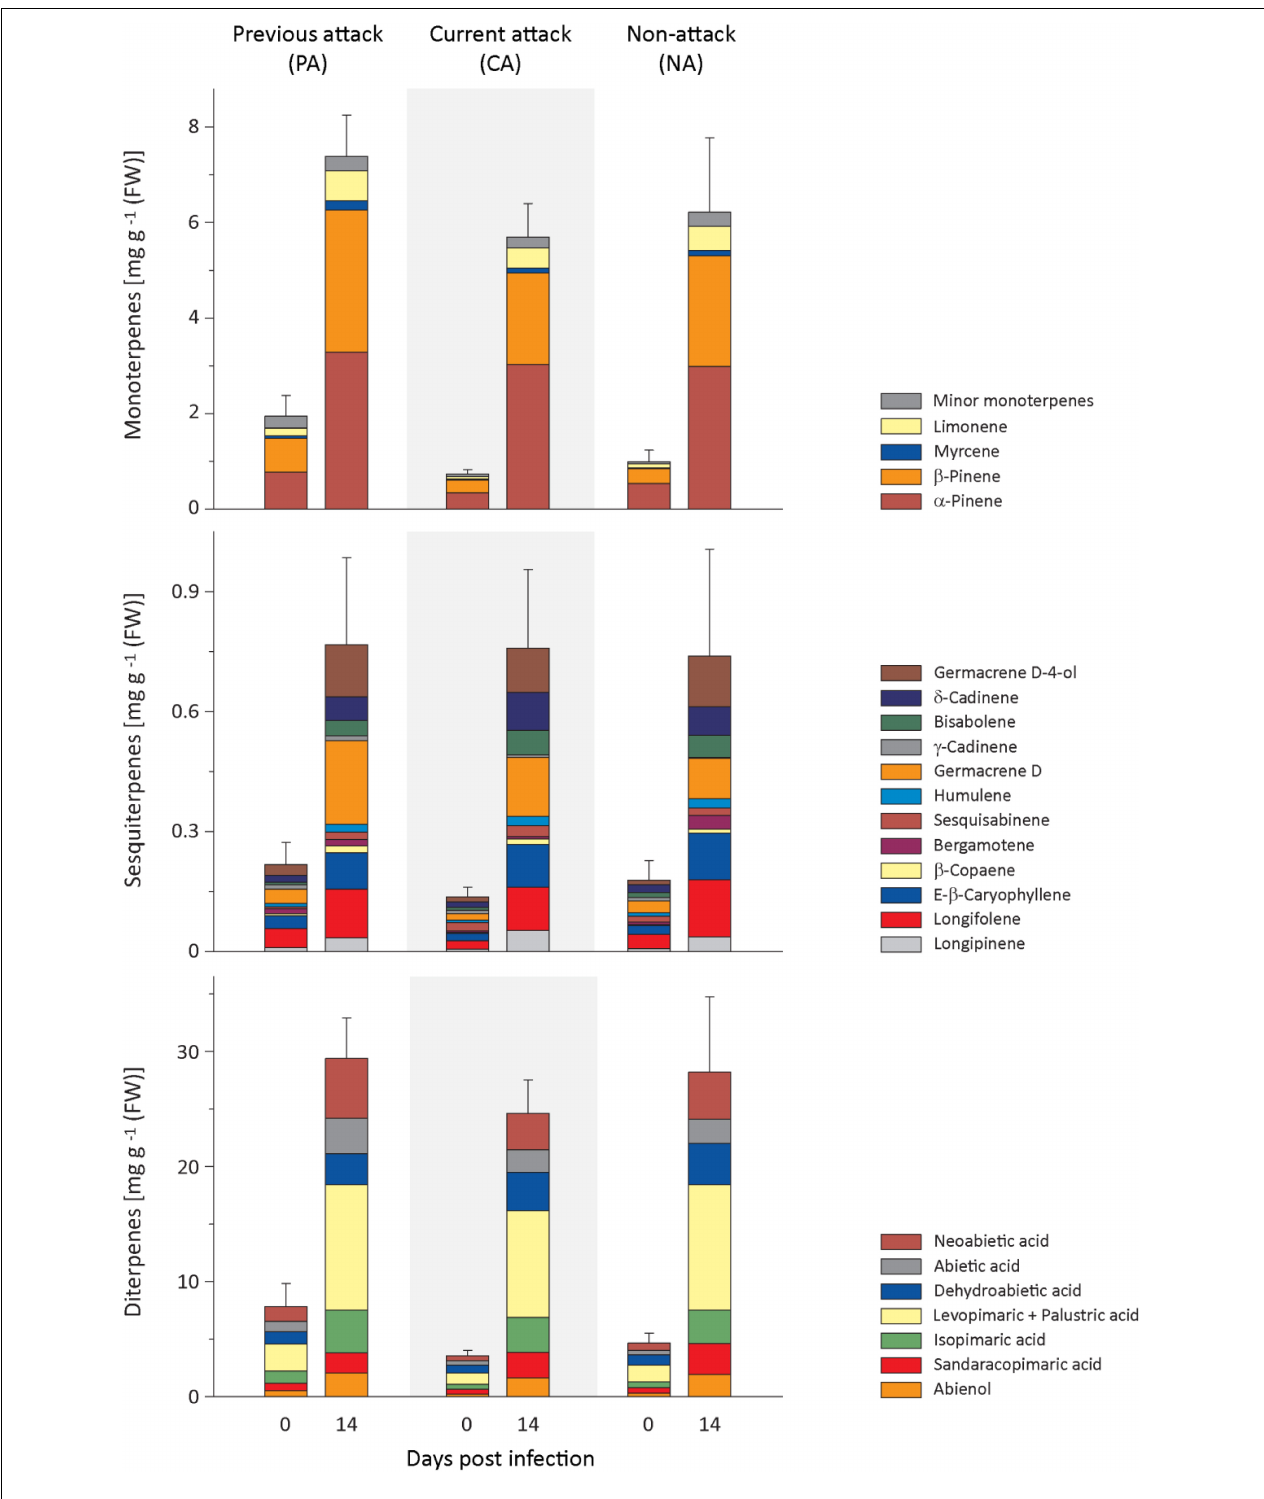
FIGURE 2 | Induction of resin terpenes in spruce bark after Endoconidiophora polonica infection. The concentrations of the major resin monoterpenes (upper panel) , sesquiterpenes (middle panel) , and diterpenes (lower panel) were quantified by GC-FID analysis of bark tissue harvested before and 14 days after infection with E. polonica . Trees investigated: (1) were from a stand with a history of previous bark beetle attack, but no current attack (PA), (2) were under current attack, but had no previous history of attack (CA), or (3) had no previous nor current attack (NA). Data are means ± SE of measurements from 6 to 19 biological replicates; exact numbers are given in the Section “Materials and Methods.” Statistical values for individual compounds are given in Supplementary Tables 2, 3 .